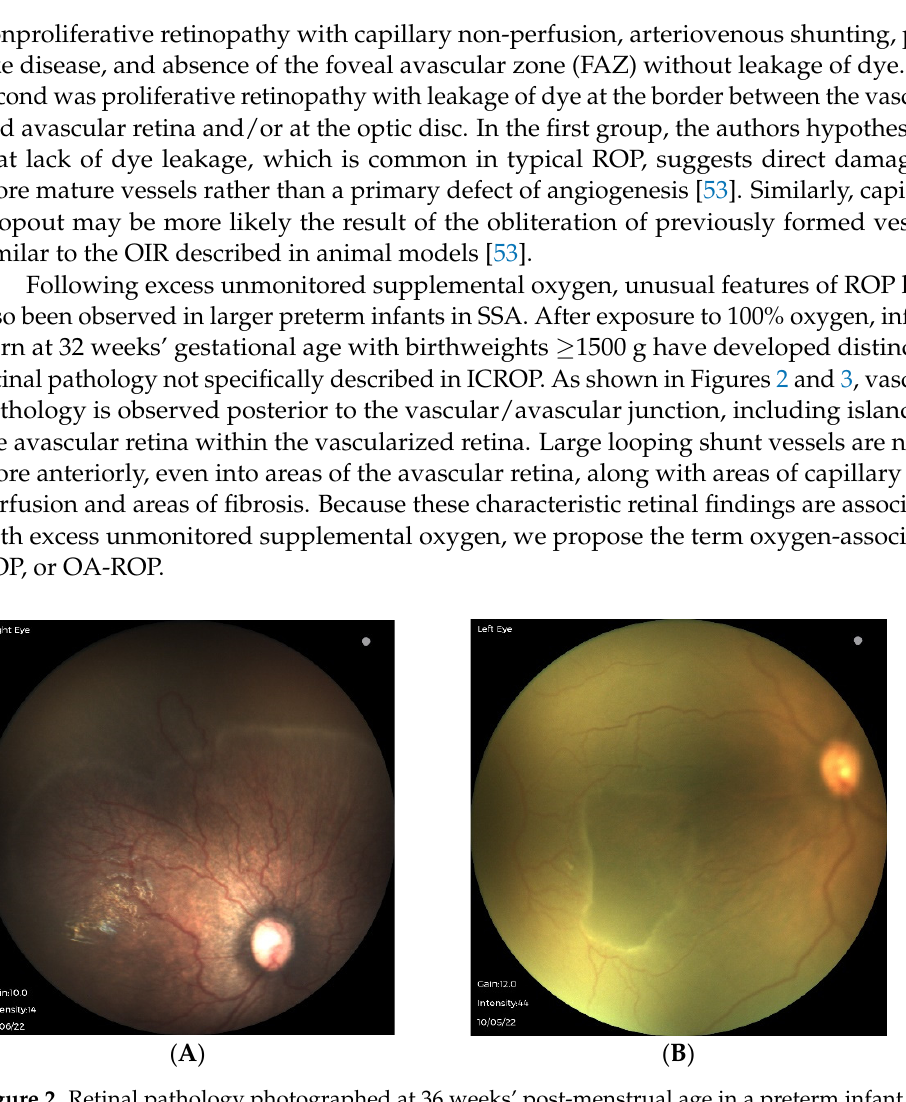
Figure 2. Retinal pathology photographed at 36 weeks’ post-menstrual age in a preterm infant born at 32 weeks and 1500 g, exposed to 100% oxygen. ( A ) The right eye has shunt vessels extending beyond the vascular–avascular junction superiorly. ( B ) The left eye has an island of avascular retina within otherwise vascularized retina nasally.